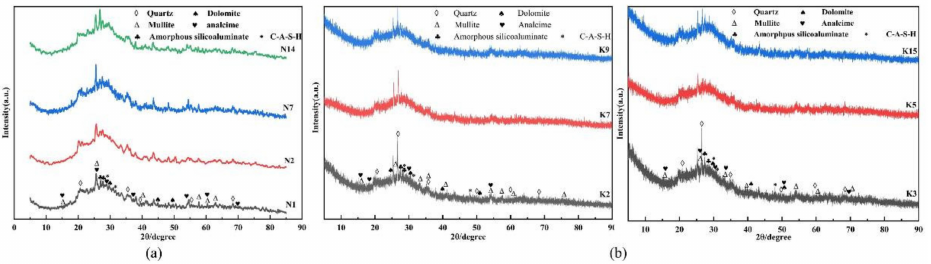
Figure 4. The 28-day XRD patterns of geopolymers: ( a ) XRD pattern of Na-based geopolymers and ( b ) XRD pattern of K-based